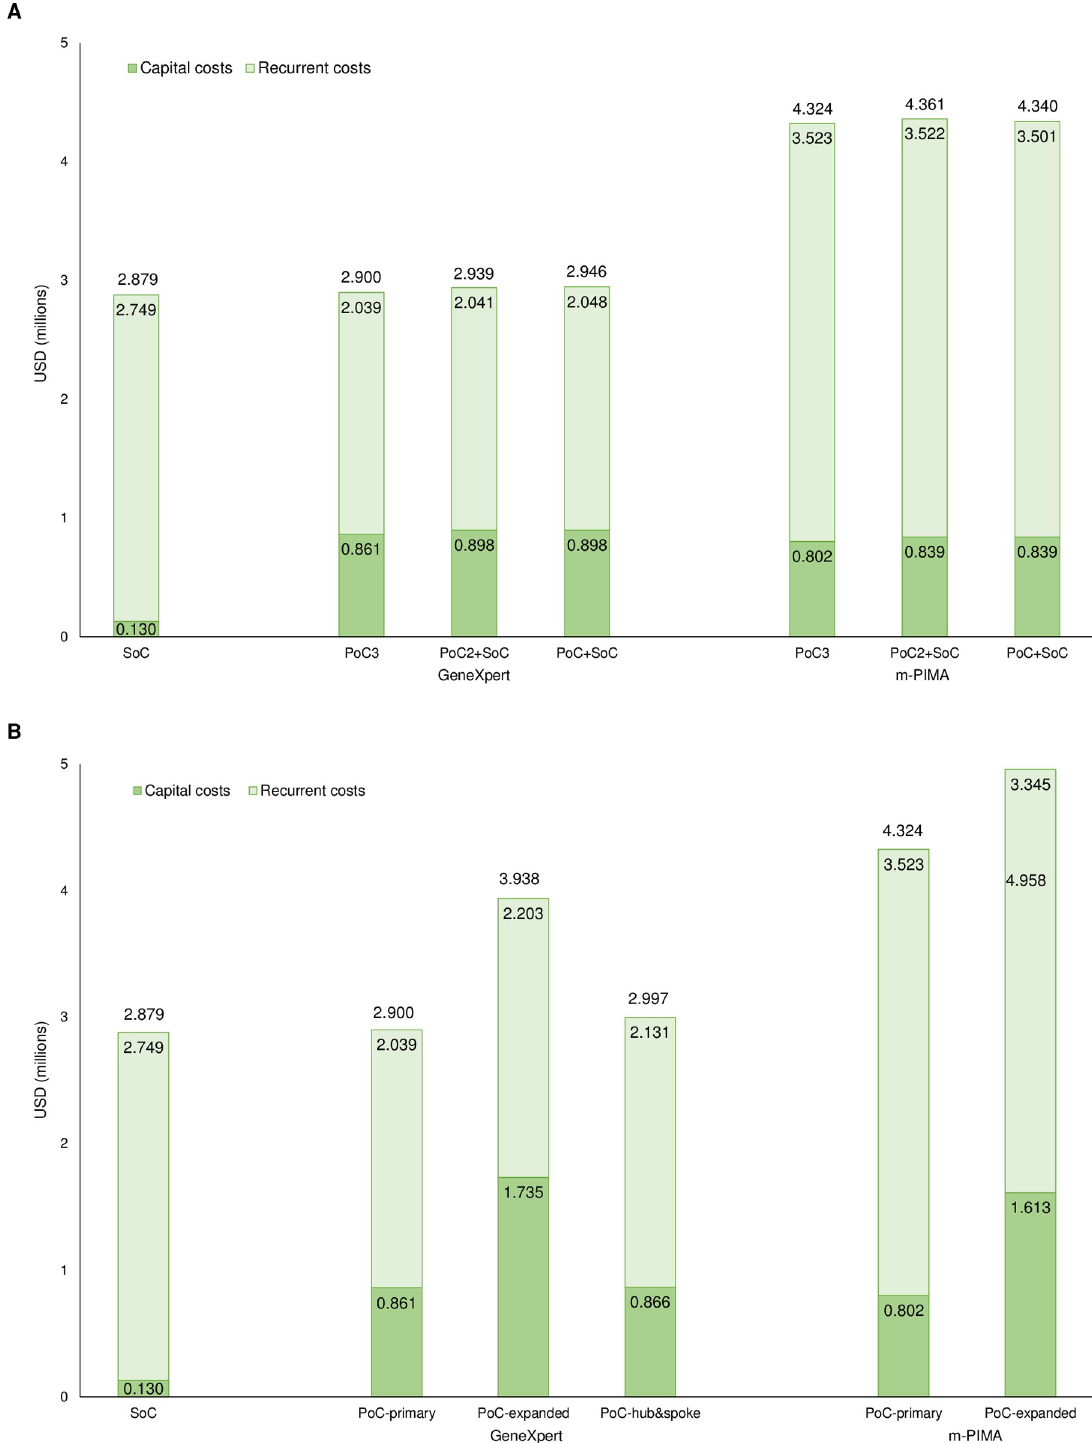
Fig 2. Capital and recurrent costs for standard of care and point-of-care testing by (A) testing algorithm and (B) implementation model. PoC: point-of-care testing; SoC: standard of care testing. Note: (A) testing algorithms are presented for the primary implementation model; (B) implementation models are presented for the PoC3